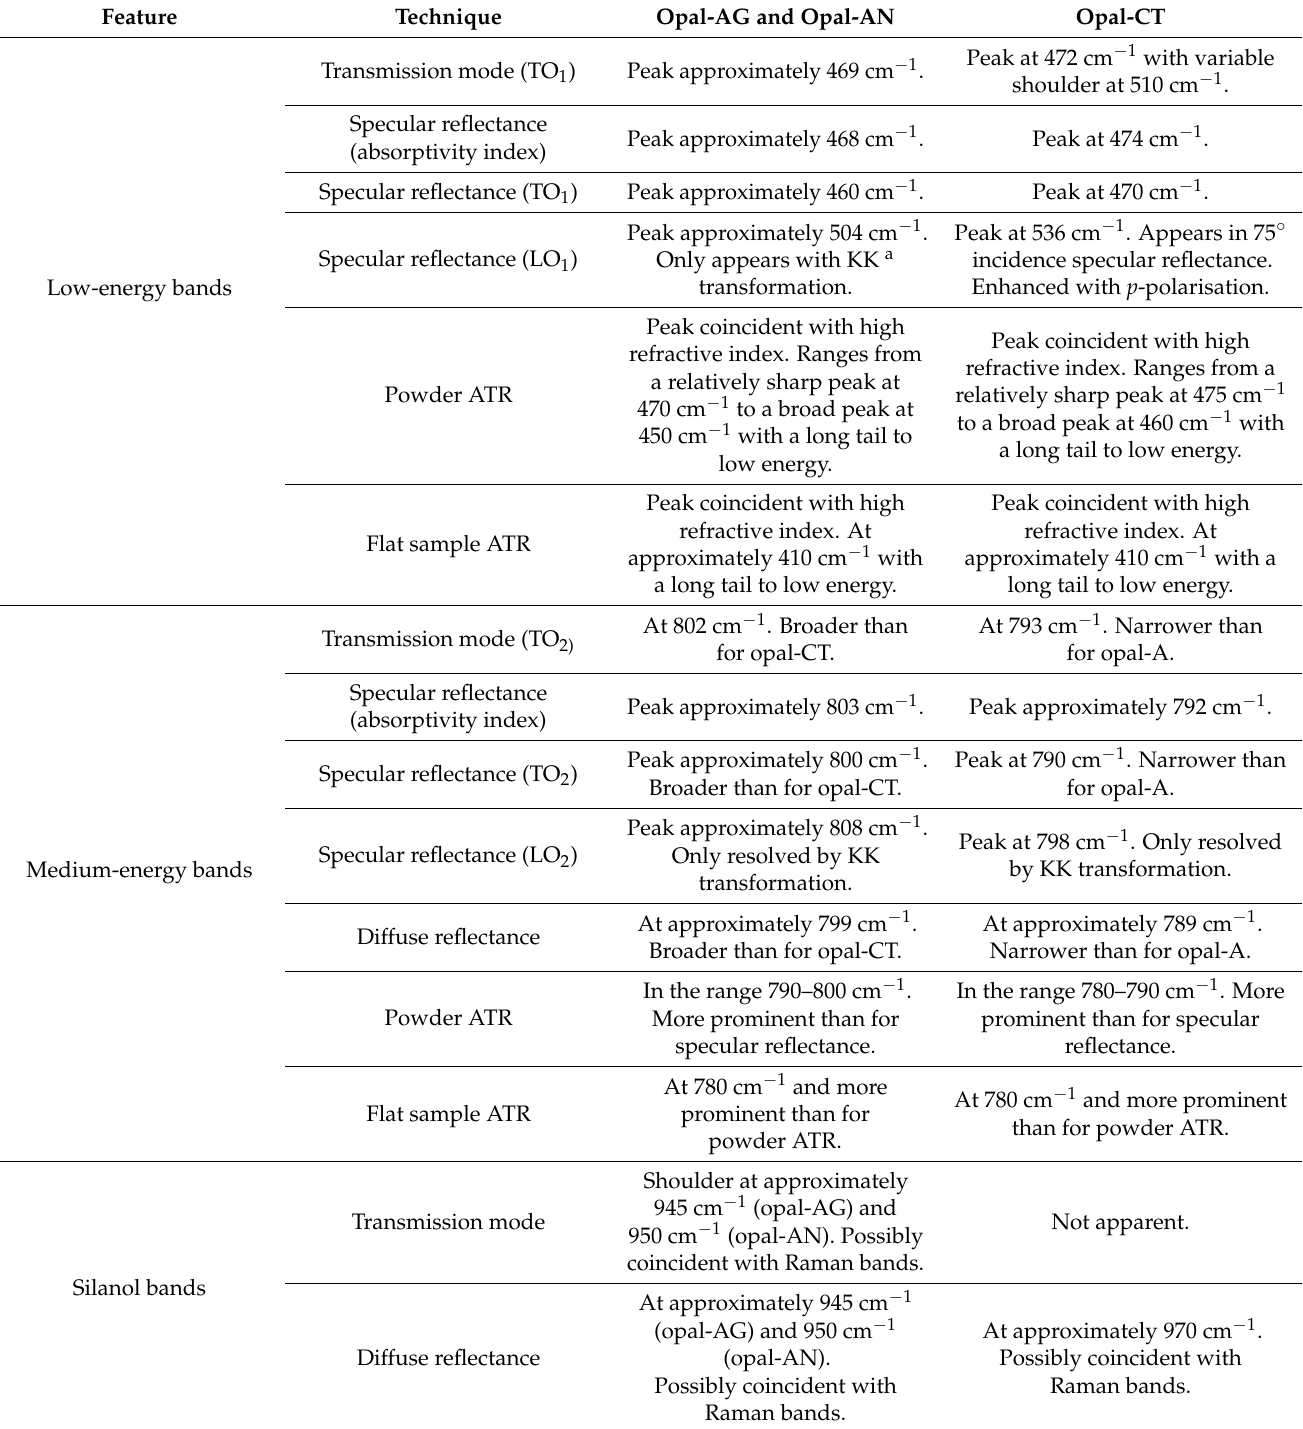
Table 7. Compiled spectroscopic data for opal A and opal CT samples. Values given are